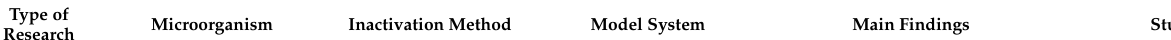
Table 4. Experimental and clinical studies on the effects of inanimate probiotics in diabetes mellitus and